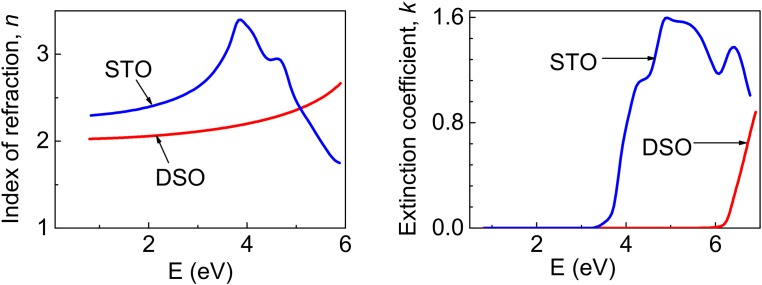
Index of refraction (a) and Extinction coefficient (b) of SrTiO3 and DyScO3 substrates.